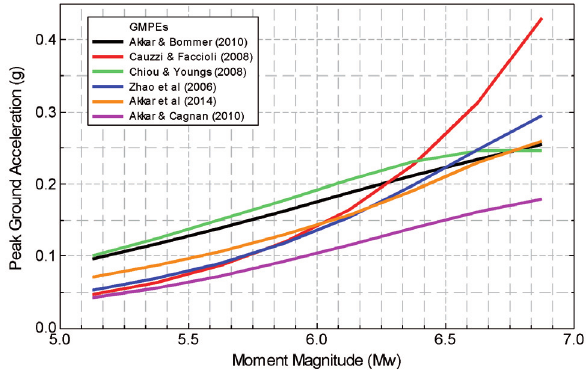
Figure 3. Median ground motion estimations for different GMPEs used to characterize the ground motion epistemic uncertainties for active shallow crust. Peak Ground Acceleration (PGA) plotted as function of different moment magnitudes for a fixed hypocentral distance of 10